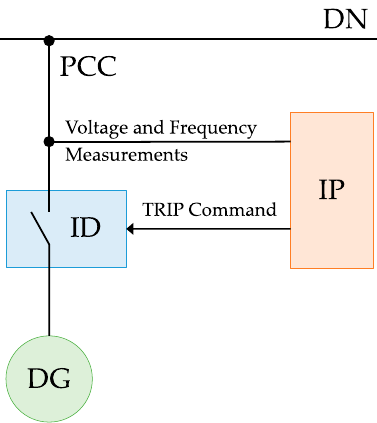
Figure 1. Schematic block diagram of an Interface Protection System (IPS). IP: Interface Protection, ID: Interface Device, DG: Distributed Generator, DN: Distribution Network, PCC: Point of Common Coupling.